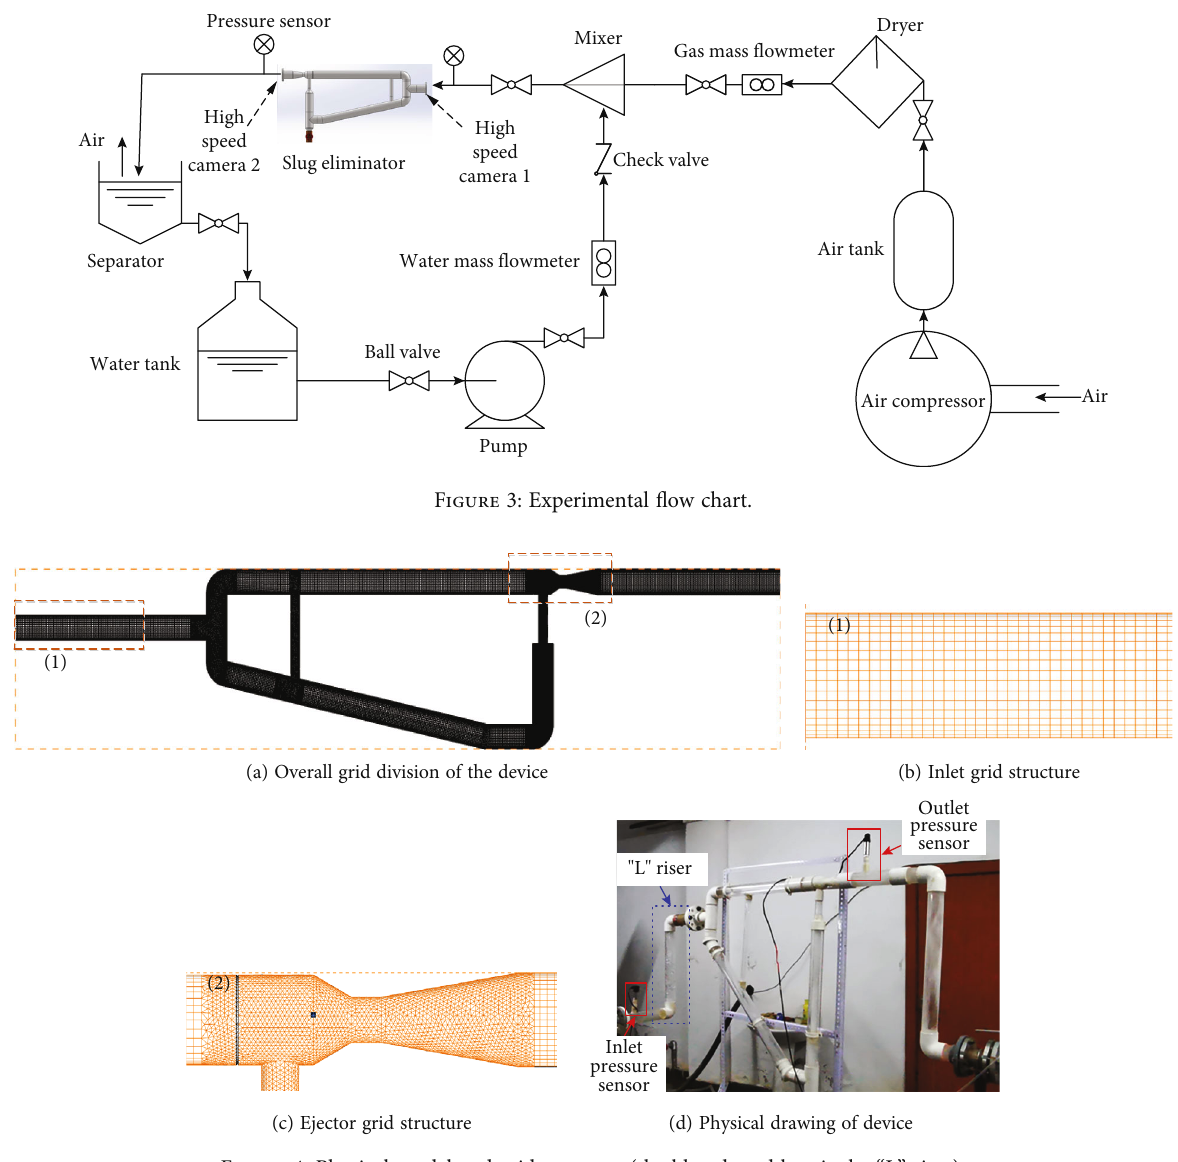
Figure 4: Physical model and grid structure (the blue dotted box is the “ L ”